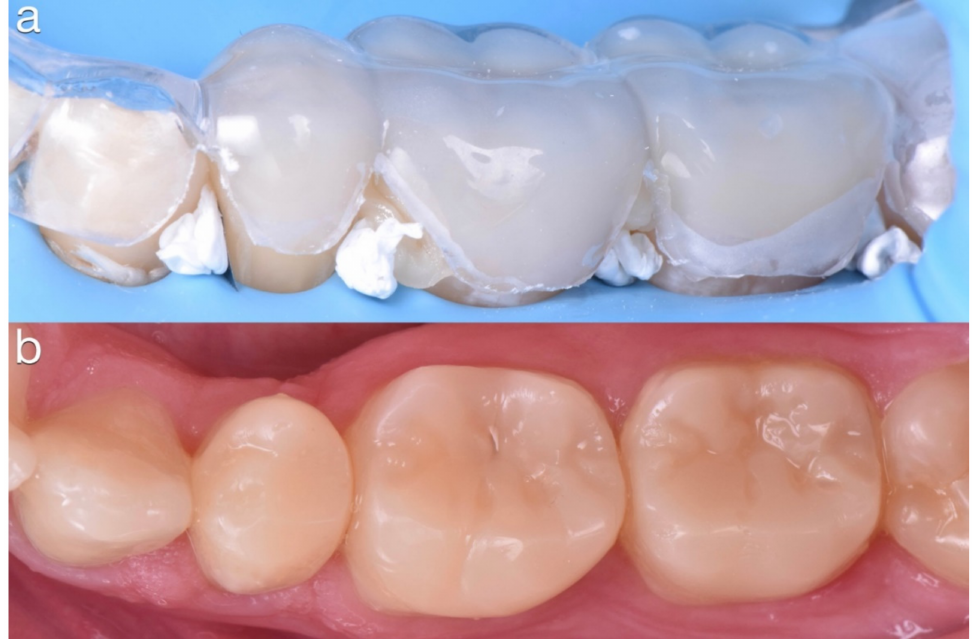
Figure 21. ( a ) Plastic tray filled with preheated hybrid composite and placed in the corresponding quadrant. ( b ) Final